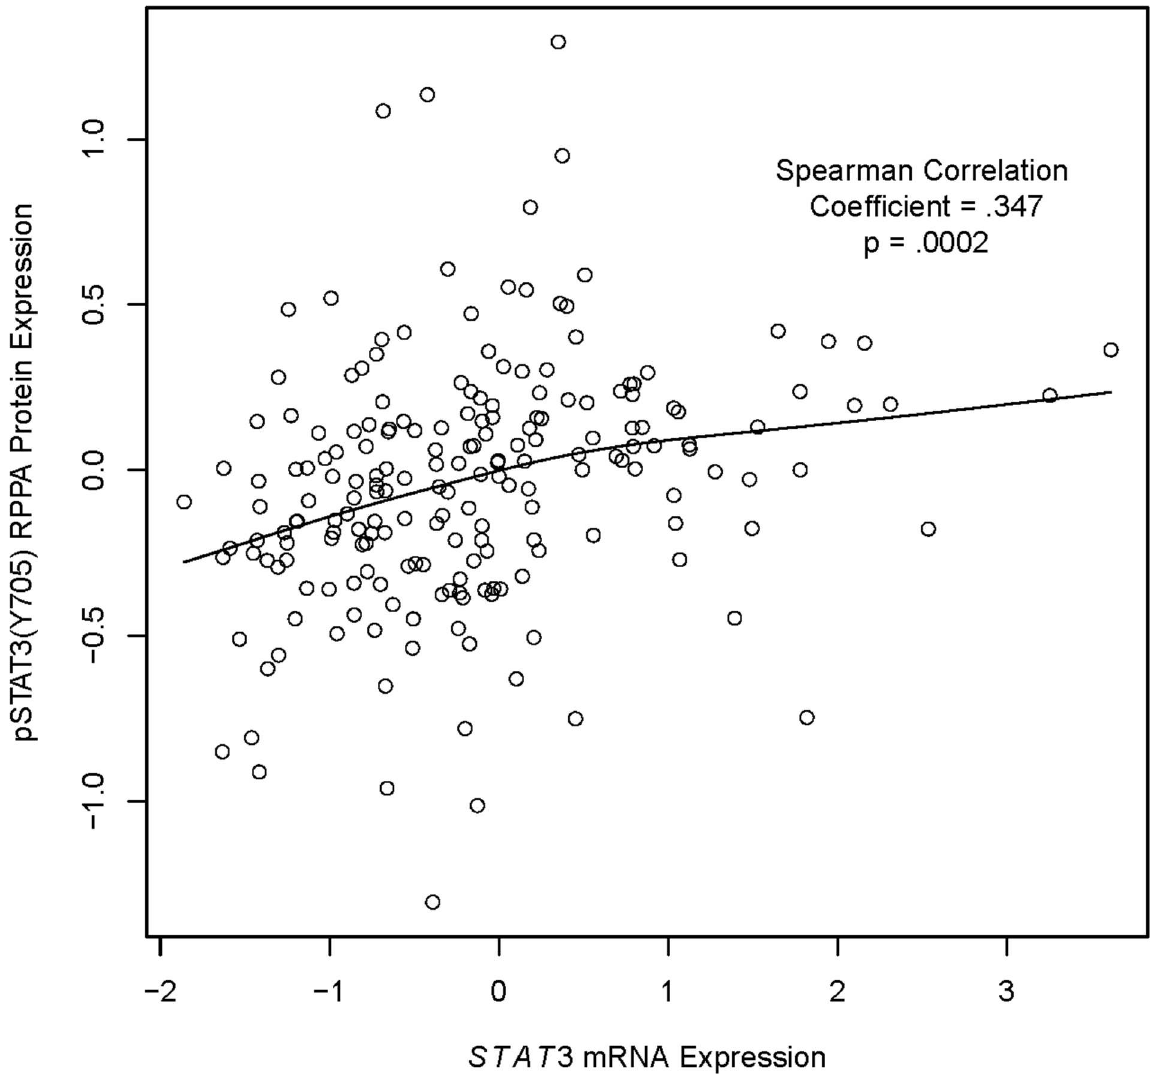
Fig 3. pSTAT3(Y705) expression correlateswith STAT3 mRNA expression. Spearman’s test indicates a significantcorrelation between STAT3 mRNA expression and pSTAT3(Y705) protein expression(p = 6.63x10 -7, , correlation=